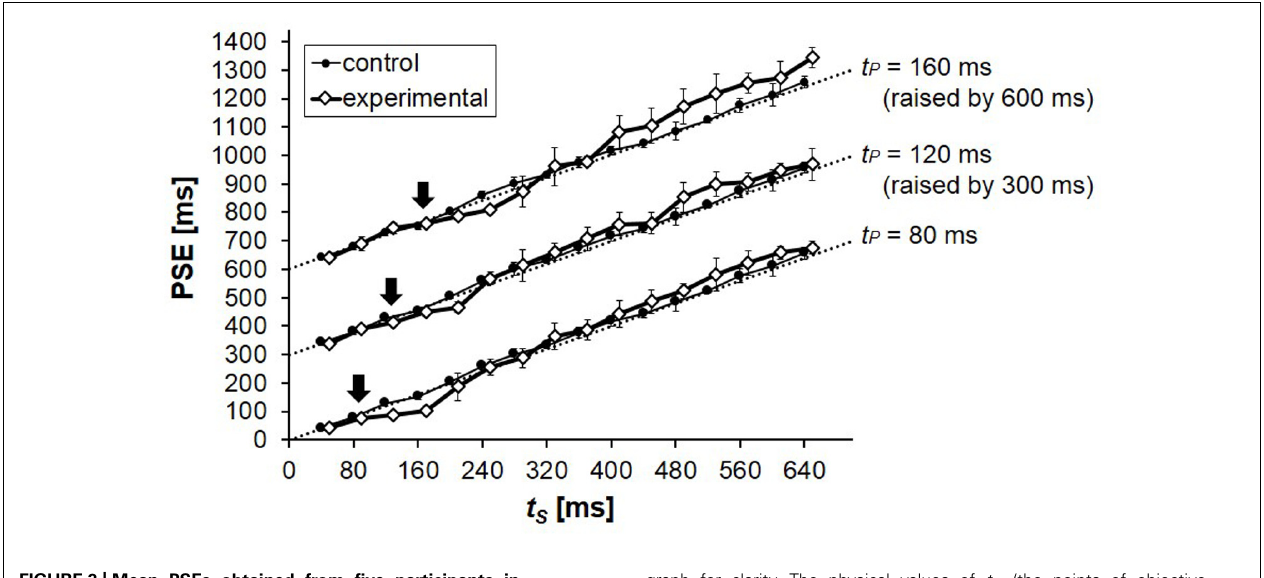
graph for clarity. The physical values of t S (the points of objective equality) are indicated by dotted lines, on which t P values are indicated by arrows. Error bars represent standard deviations between